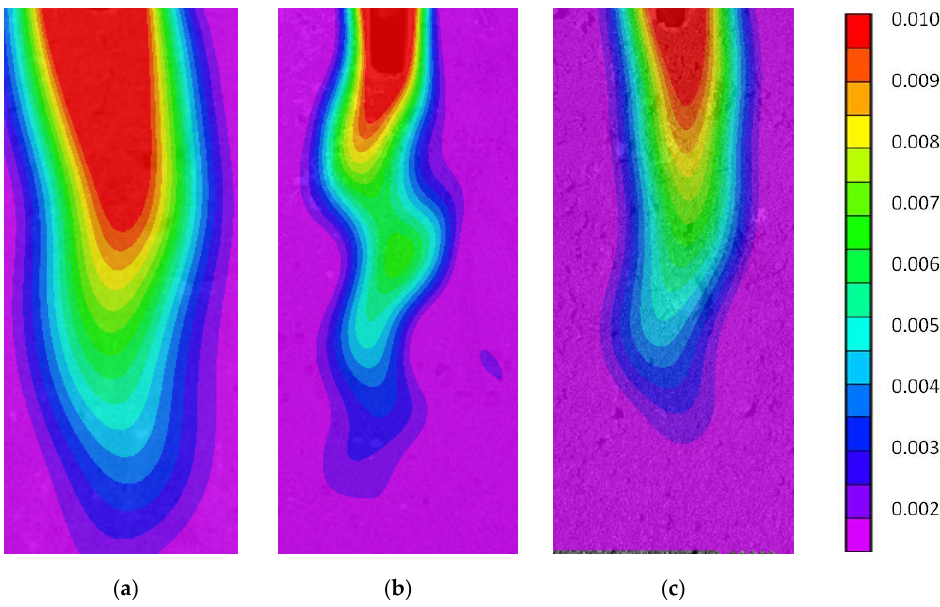
Figure 19. Images of deformation propagation map in the elastic zone obtained using Digital Image Correlation (DIC) for samples: ( a ) NC, ( b ) SFRC and ( c ) RSFRC. The above observation of the WST test confirmed the picture showing the scratches formed in the ISF sample (Figure 20).